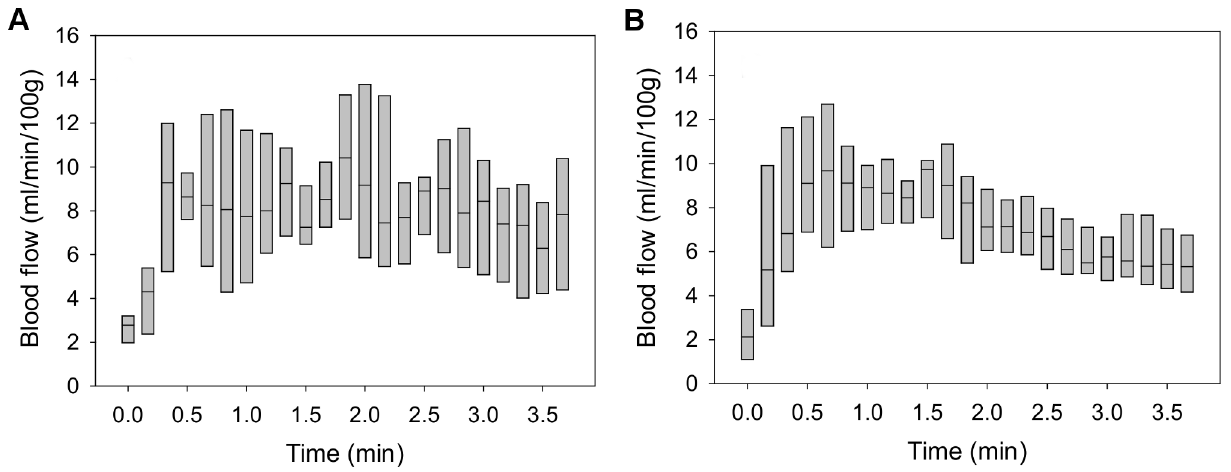
Figure 4. Average reactive hyperemia blood flow data. Raw blood flow data was filtered with low pass filters. The filtered data was averaged over all six subjects in each group. Panel (A) shows the averaged data for people with SCI. Panel (B) shows the averaged data for people without SCI.